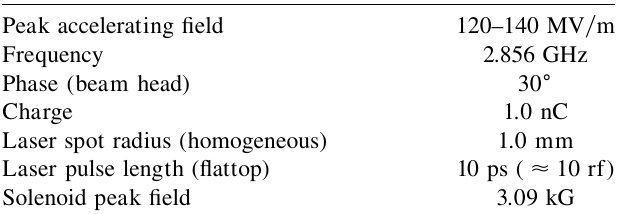
TABLE I. Photoinjector parameters. The phase is relative to the zero of the